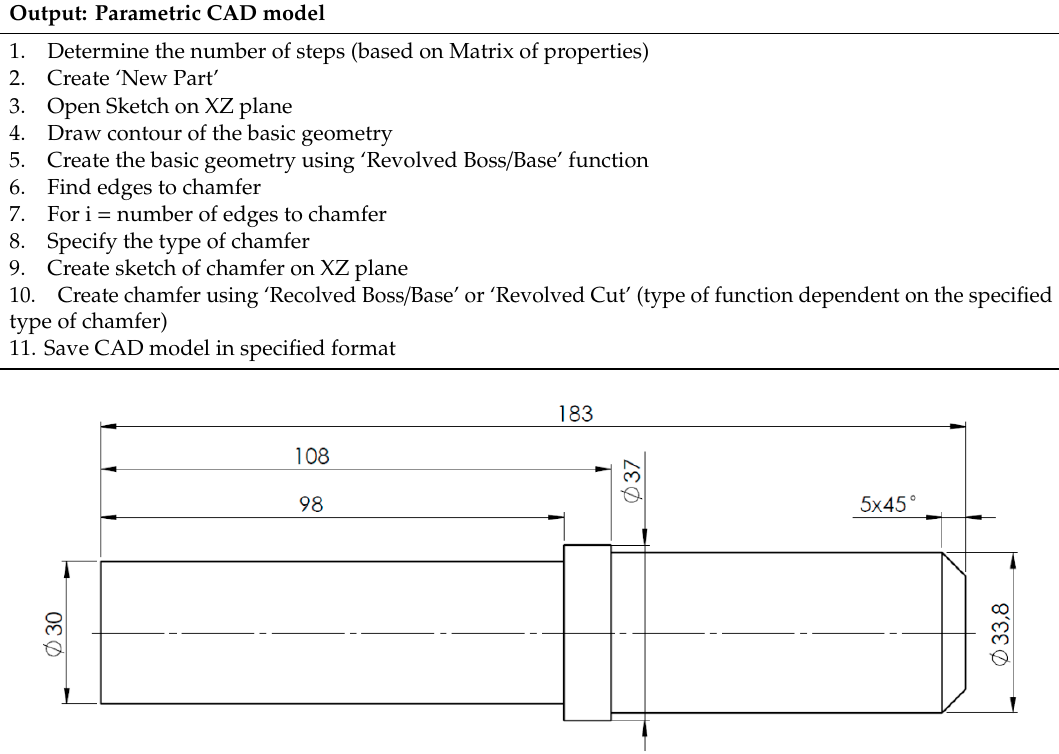
Figure 10. Identified part geometry.